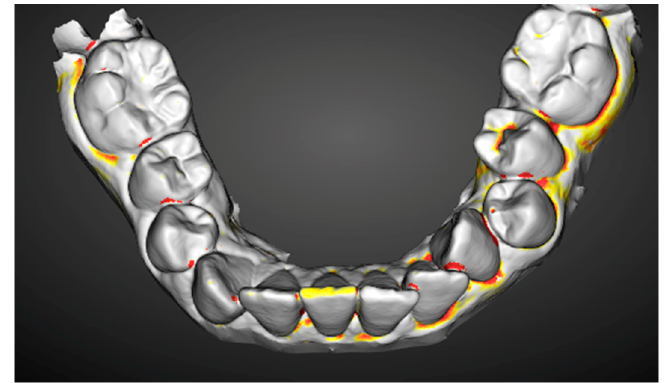
Figure 5. Example of scan presented to the